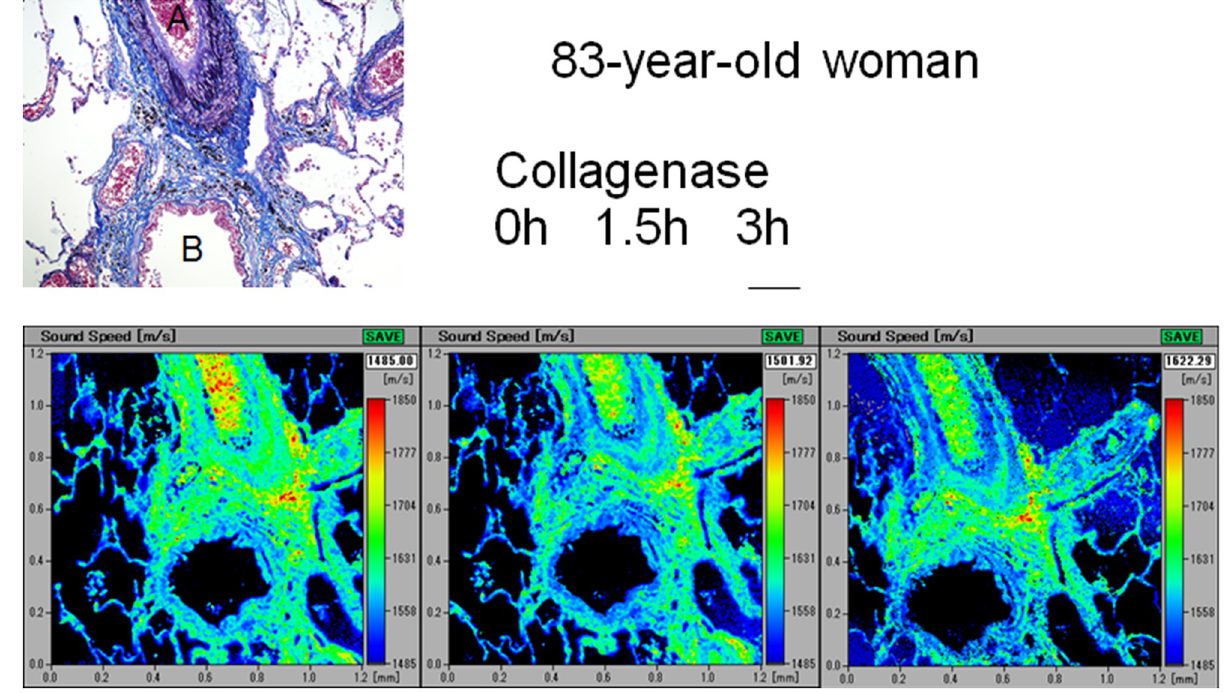
Fig 8. Alteration in SOS values of the old lung after collagenase digestion. SOS values of the arteriolar and bronchiolar walls and alveoli in the old lung preserve SOS values after digestion. The blood contents in the arterioles serve as an internal control for collagenase treatment and exhibit a gradual decrease in SOS values after digestion. The corresponding LM images of sections stained with Verhoeff’s elastic and Masson’s trichrome staining are presented in the upper left corner. A, arterioles; B, bronchioles. Scale bar = 200 μ